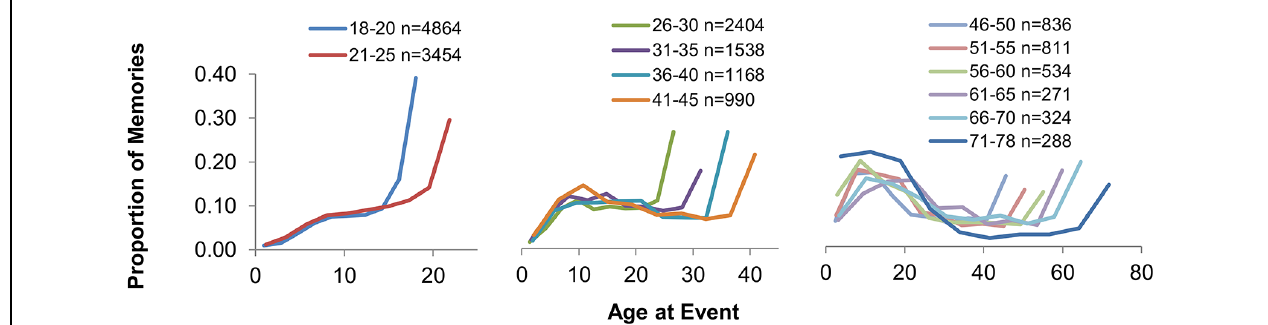
(an increase in AMs recalled from adolescence to early adulthood) emerged in subjects in their mid-to-late 20s and was most prominent in subjects older than 45 years old. Childhood amnesia (a paucity of AMs recalled from the first few years of life) was clearly observed in younger subjects (18–45 years old). Its absence in older subjects (46–78 years old) is likely due to our dating procedure, as the first 10th of life in this age group is longer than the typical interval of childhood amnesia.